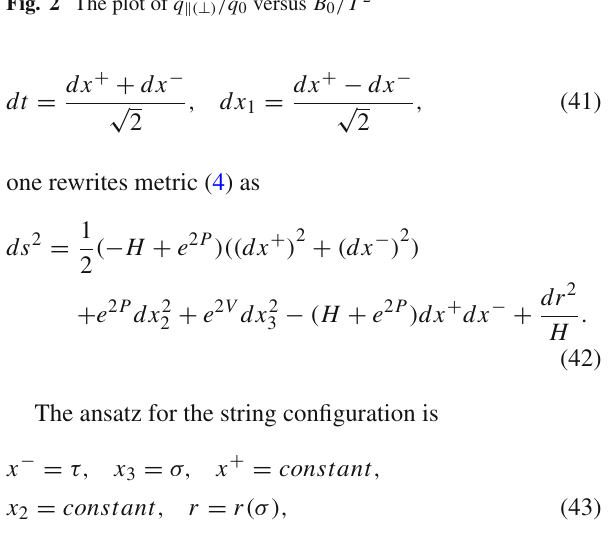
Fig. 2 The plot of ˆ q (cid:11) ( ⊥ ) / ˆ q 0 versus B 0 / T